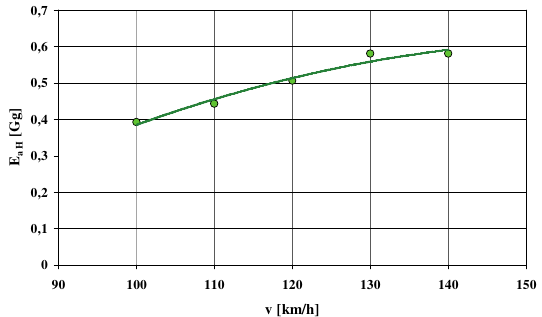
Fig. 19. Dependence of the national annual emission of carbon dioxide from passenger cars upon the average velocity, under model conditions of urban traffic